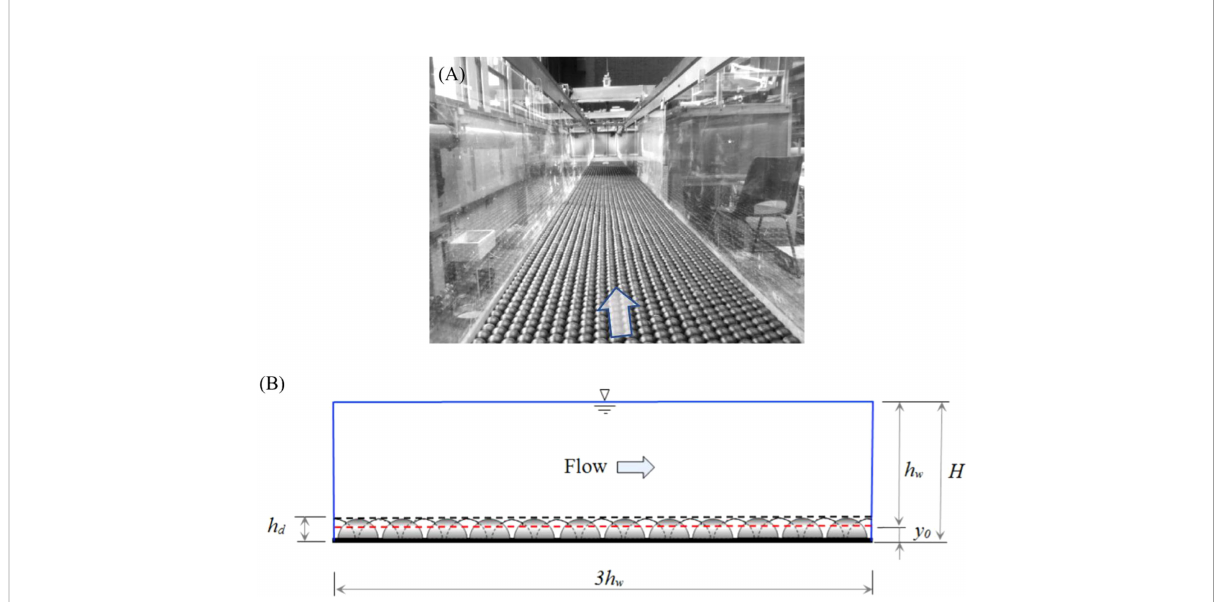
FIGURE 1 (A) Frontal view of the prototype fl ume and (B) longitudinal view through the centerline with rough bed